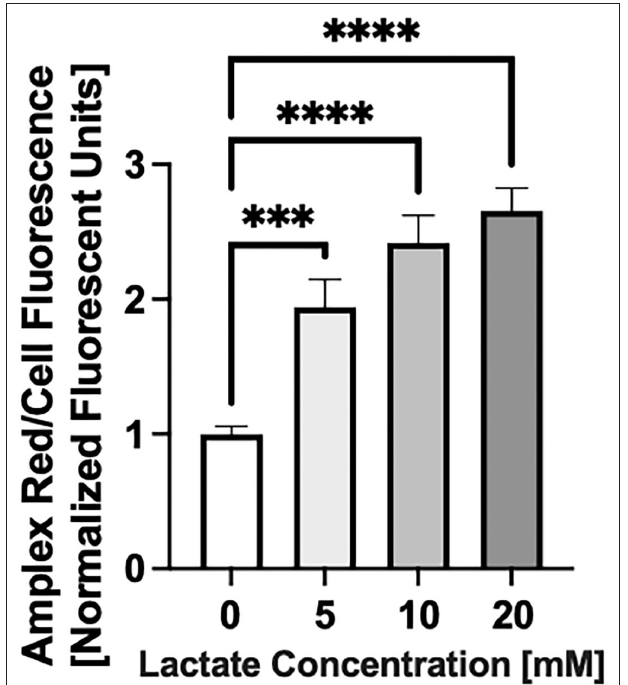
FIGURE 4 | Reactive Oxygen Species (ROS) production with chronic lactate treatment. NRVMs were treated for 48h with various concentrations of lactate and reactive oxygen species0 (total cellular superoxide plus hydrogen peroxide) assessed. Data shows a representative result from a single NRVM preparation. N = average of 15 wells on a 96-well plate. error bars show standard error of the mean, *** p < 0.001, **** p <